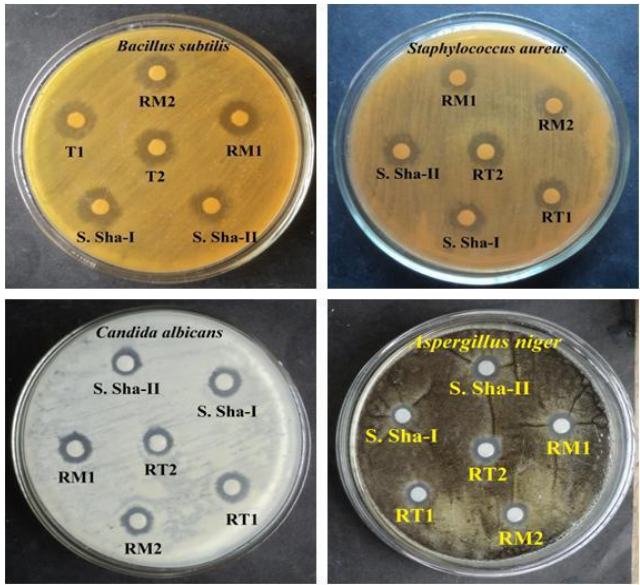
Figure 8. Antibacterial activity of Bacillus subtilis and Staphylococcus aureus. Table 2. Antimicrobial activity of Co(II) and Ni(II)